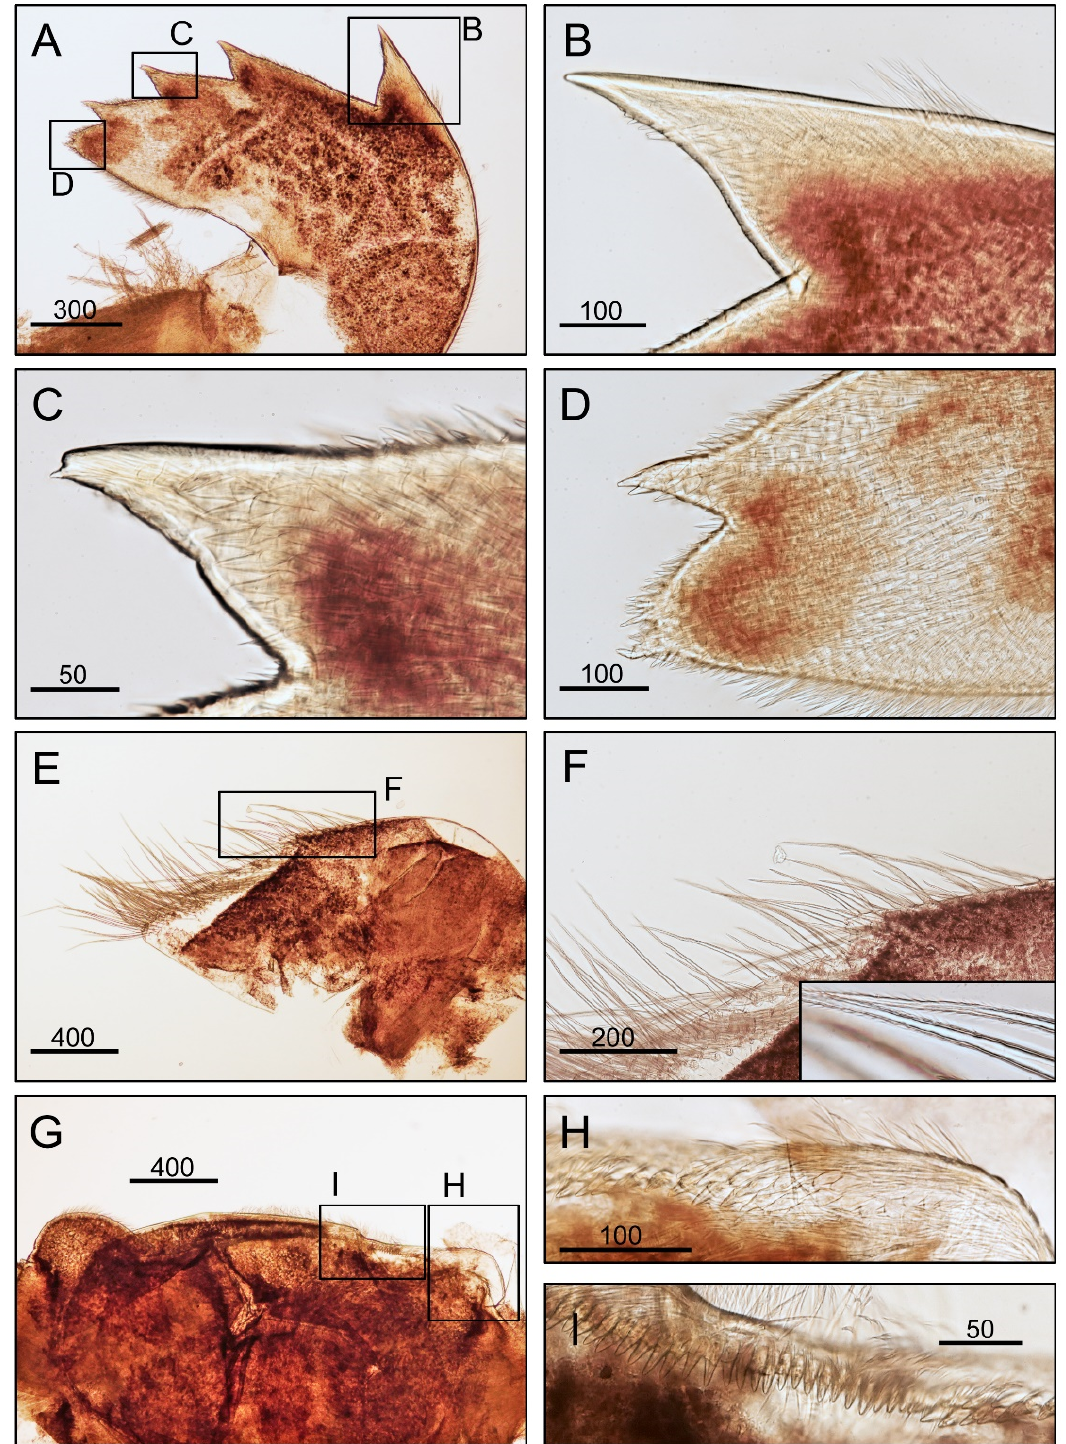
Figure 11. Conchoderma hunteri. ( A ) Mandible, showing five teeth. ( B ) First tooth of mandible. ( C ) 3rd tooth of the mandible. ( D ) Small 5th tooth of the mandible, size comparable to the inferior angle. ( E ) Mandibulary palp. ( F ) Serrulate setae at margin of palp. ( G ) Labrum. ( H ) Cutting edge of labrum showing small teeth. Scale bars in μ m.